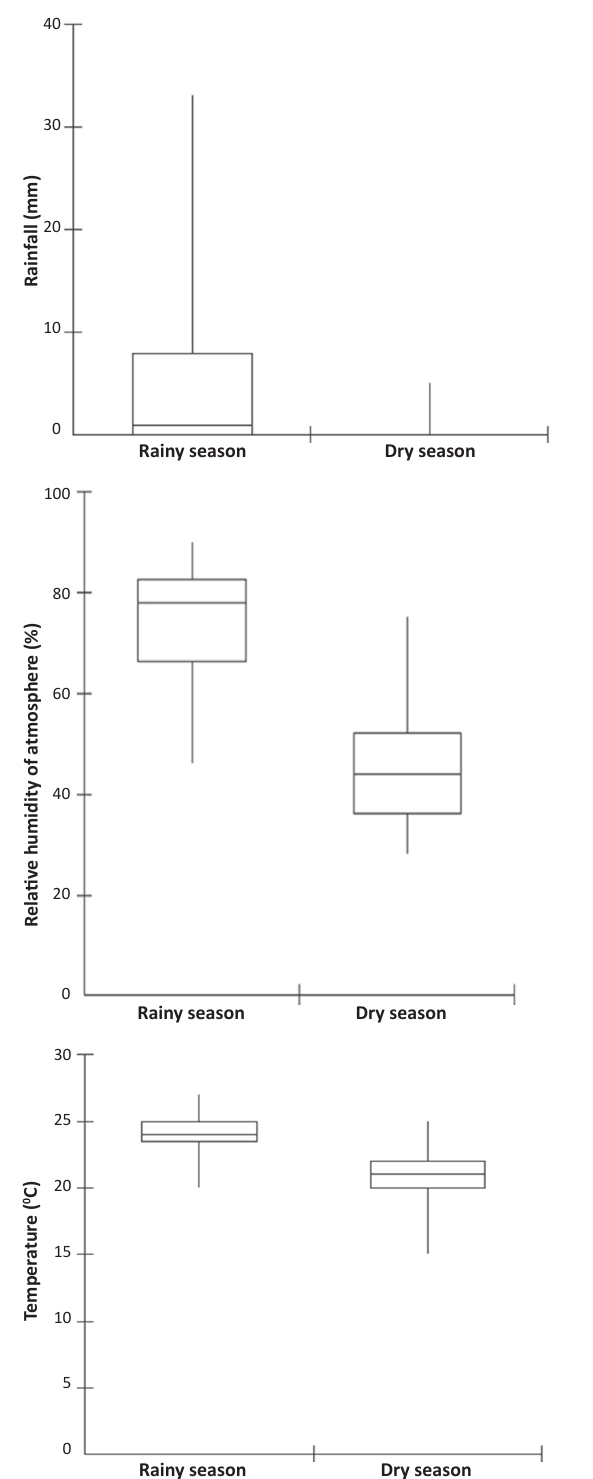
Figure 11. Comparison of humidity, temperature and rainfall between stations dry and rainy in the Parque Ecológico